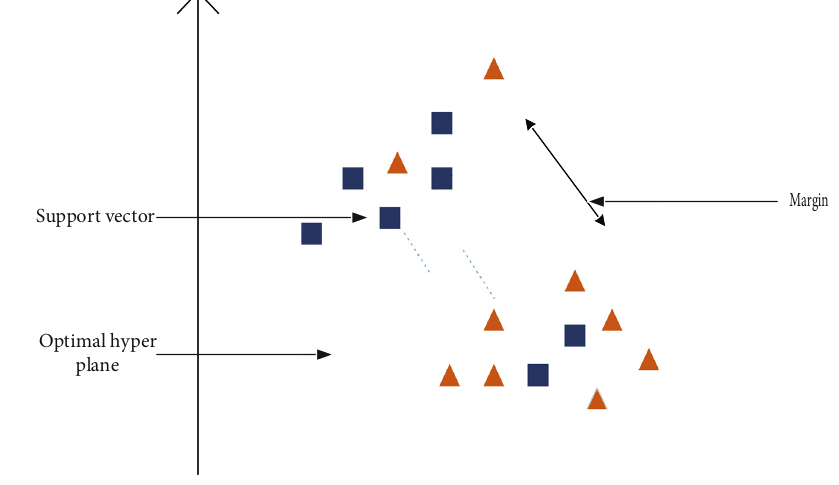
Figure 4: Representation of support vector